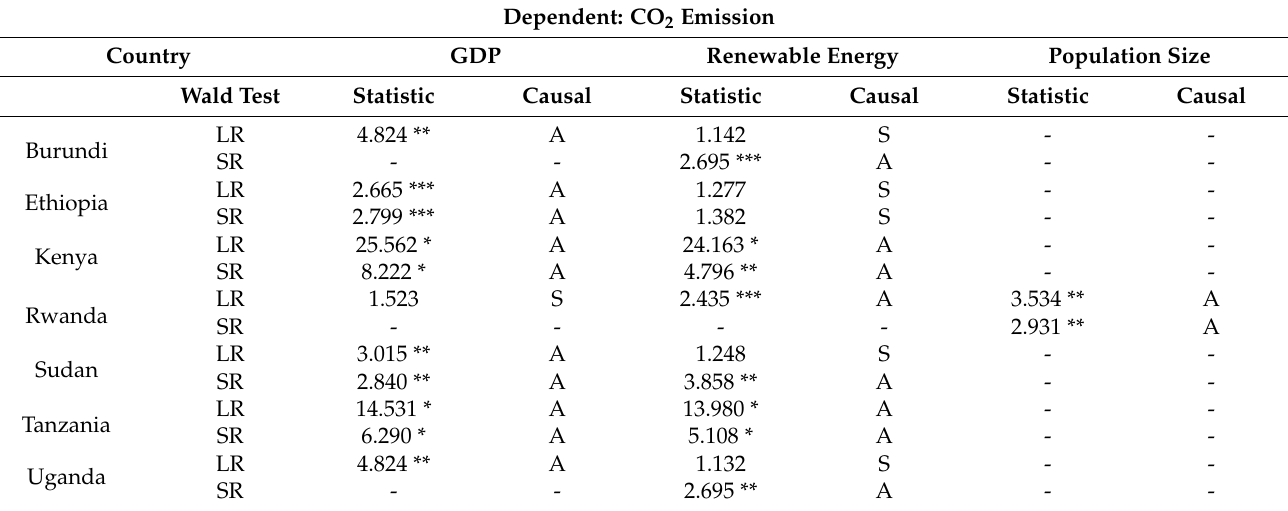
Table 10. Wald test for long- and short-run asymmetry and symmetry restrictions. Dependent: CO 2 Emission